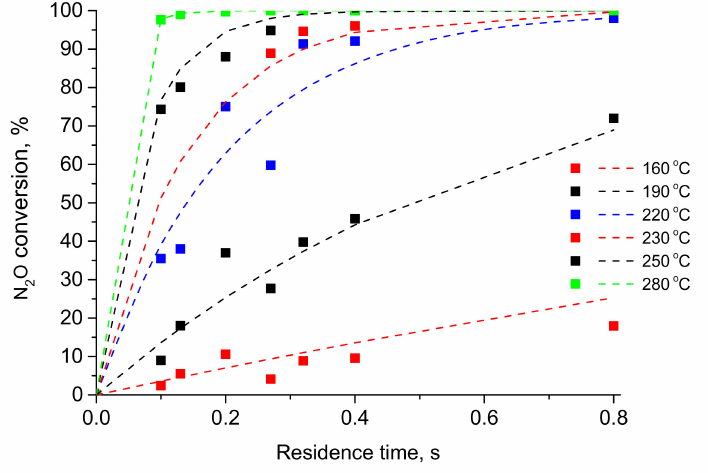
Figure 1. Conversion of N 2 O on Cs/Ni-Co oxide catalyst vs. residence time at different temperatures. Symbols indicate the experimental data. Lines indicate the results of modeling based on estimated parameters.